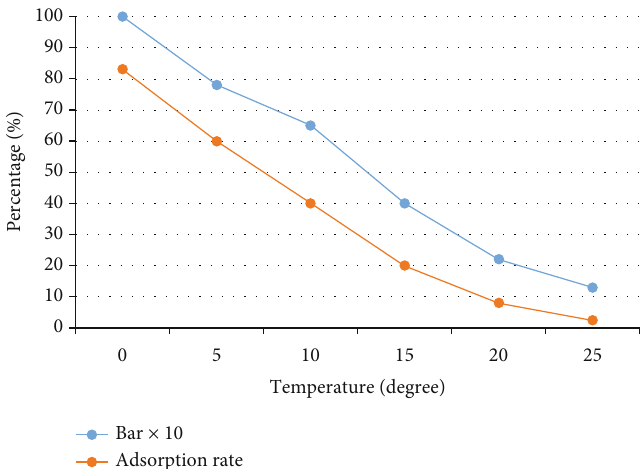
Figure 8: Adsorption rate and pressure versus temperature, with average surface area of 1442.70 m 2 /g. The average values for pore volume (PV) are 0.77, and macropore volume (MV) has an average of 0.52cm 3 /g. Table 4: Pearson ’ s coe ffi cient matrix for all features included in the research. Insigni fi cant correlation was found between the inputs, only textural features (surface area, pore volume, and macropore volume). The features with units are depicted as follows: surface area: (m 2 /g), pore volume: (cm 3 /g), macropore volume: (cm 3 /g), H: hydrogen, N: nitrogen, O